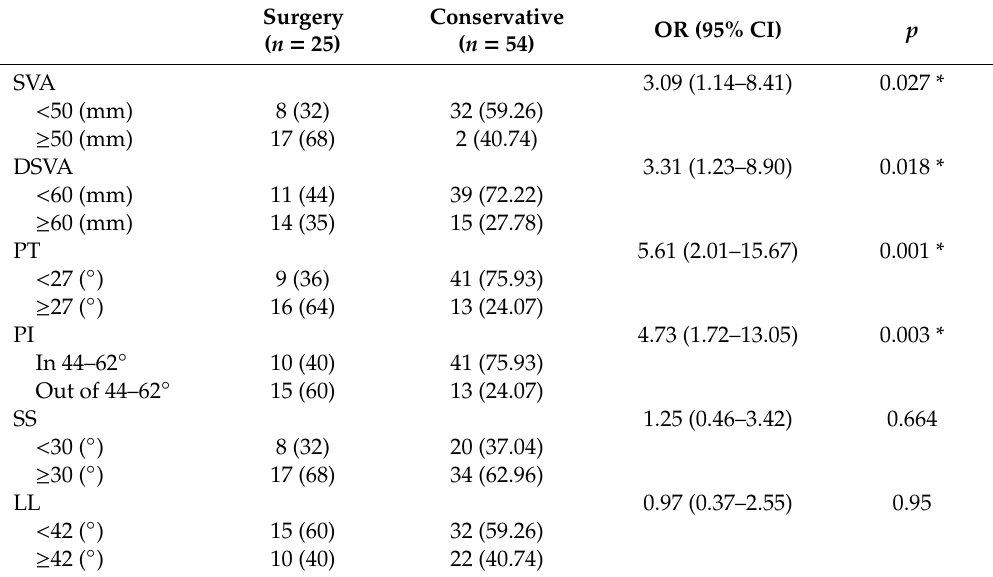
Table 3. Univariate logistic regression for cut-off points of spinopelvic parameters for the need for surgery. Surgery ( n = 25)